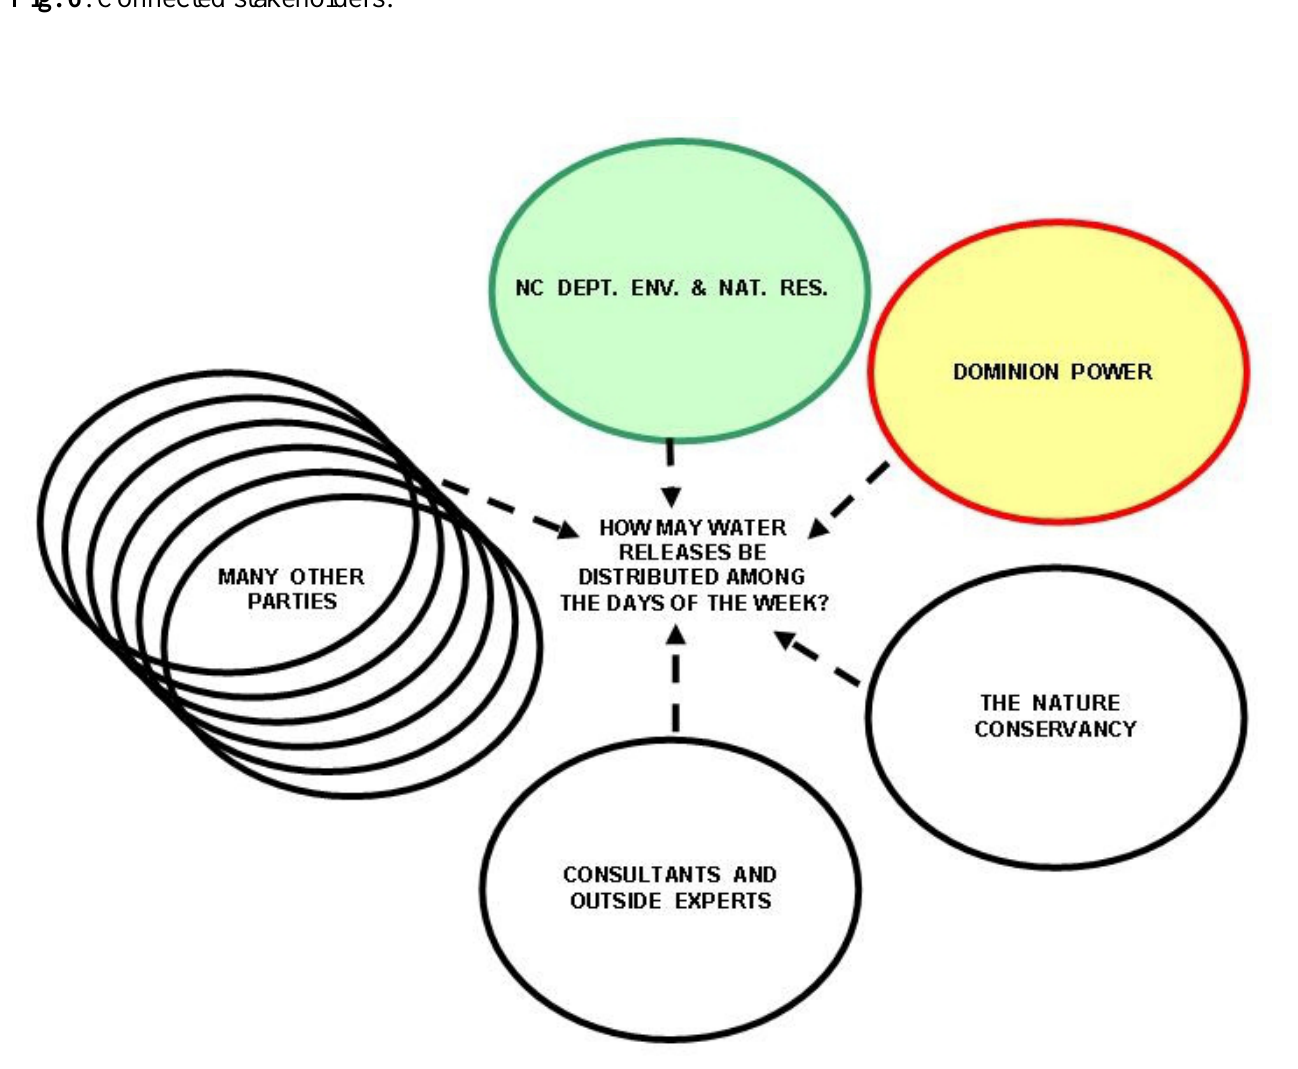
Fig. 6 . Connected